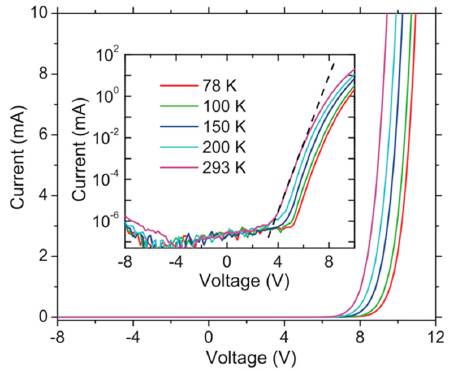
Figure 2. I ‐ V characteristics of AlGaN nanowire tunnel junction deep UV LEDs. Device size: 1 mm × 1 mm [70] . The dashed line is a guide for the eye.